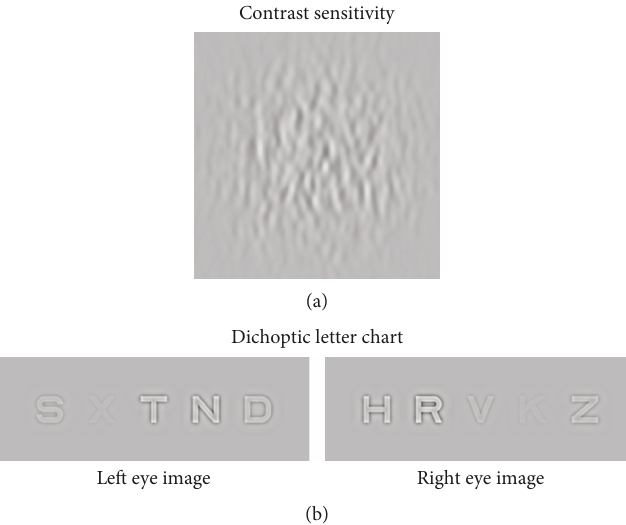
Figure 2: Test stimuli illustrations. (a) qCSF stimulus illustration. In a single-interval identi fi cation task, the subject had to judge the orientation (horizontal or vertical) of a fi ltered noise pattern of varying spatial frequency and contrast. (b) Dichoptic letter chart illustration. Five letters of 2c/d were presented at various contrasts to the left eye and 5 di ff erent letters with complementary contrasts to the right eye at the same spatial locations. So when viewed with both eyes, letters appeared overlapping on screen. Adapted from Kwon et al. [61]; Birch et al.